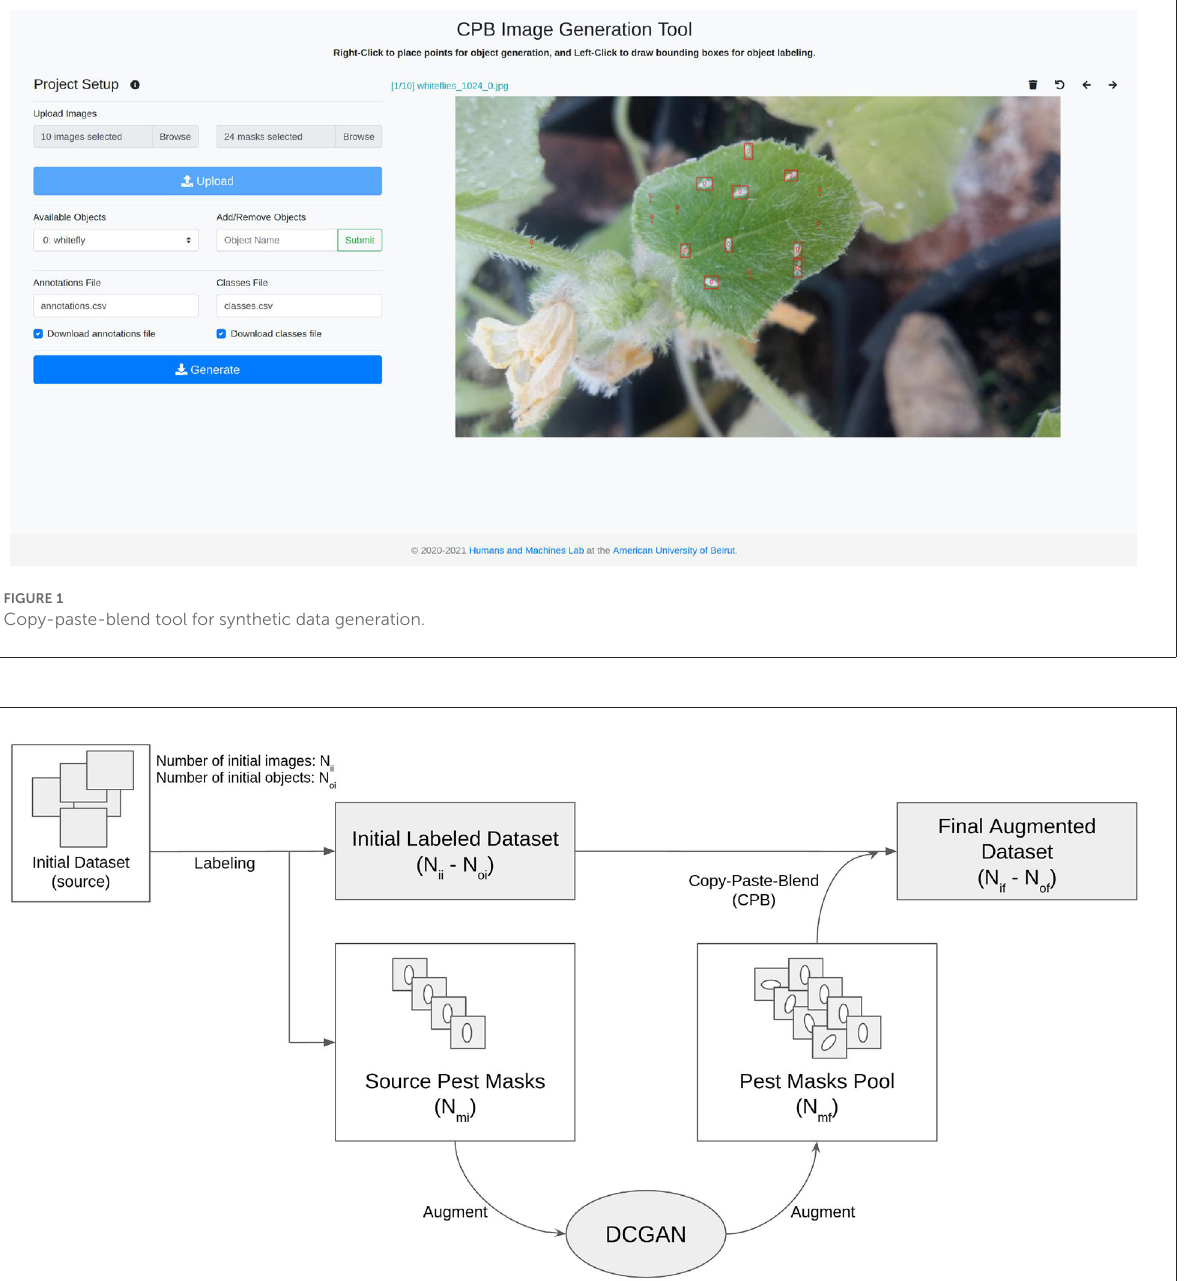
32x32 representing individual pests of varying sizes. The